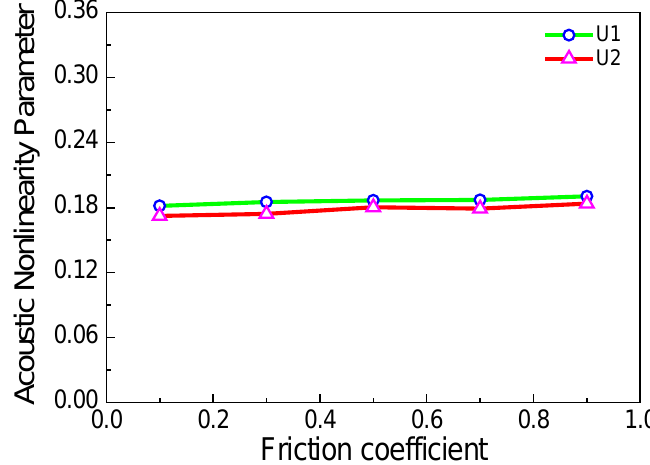
Figure 13. Acoustic nonlinearity parameter versus the friction coefficient ( c = 0.1, f = 1000 kHz, w % = 100%). Materials 2018 , 11 , x FOR PEER REVIEW